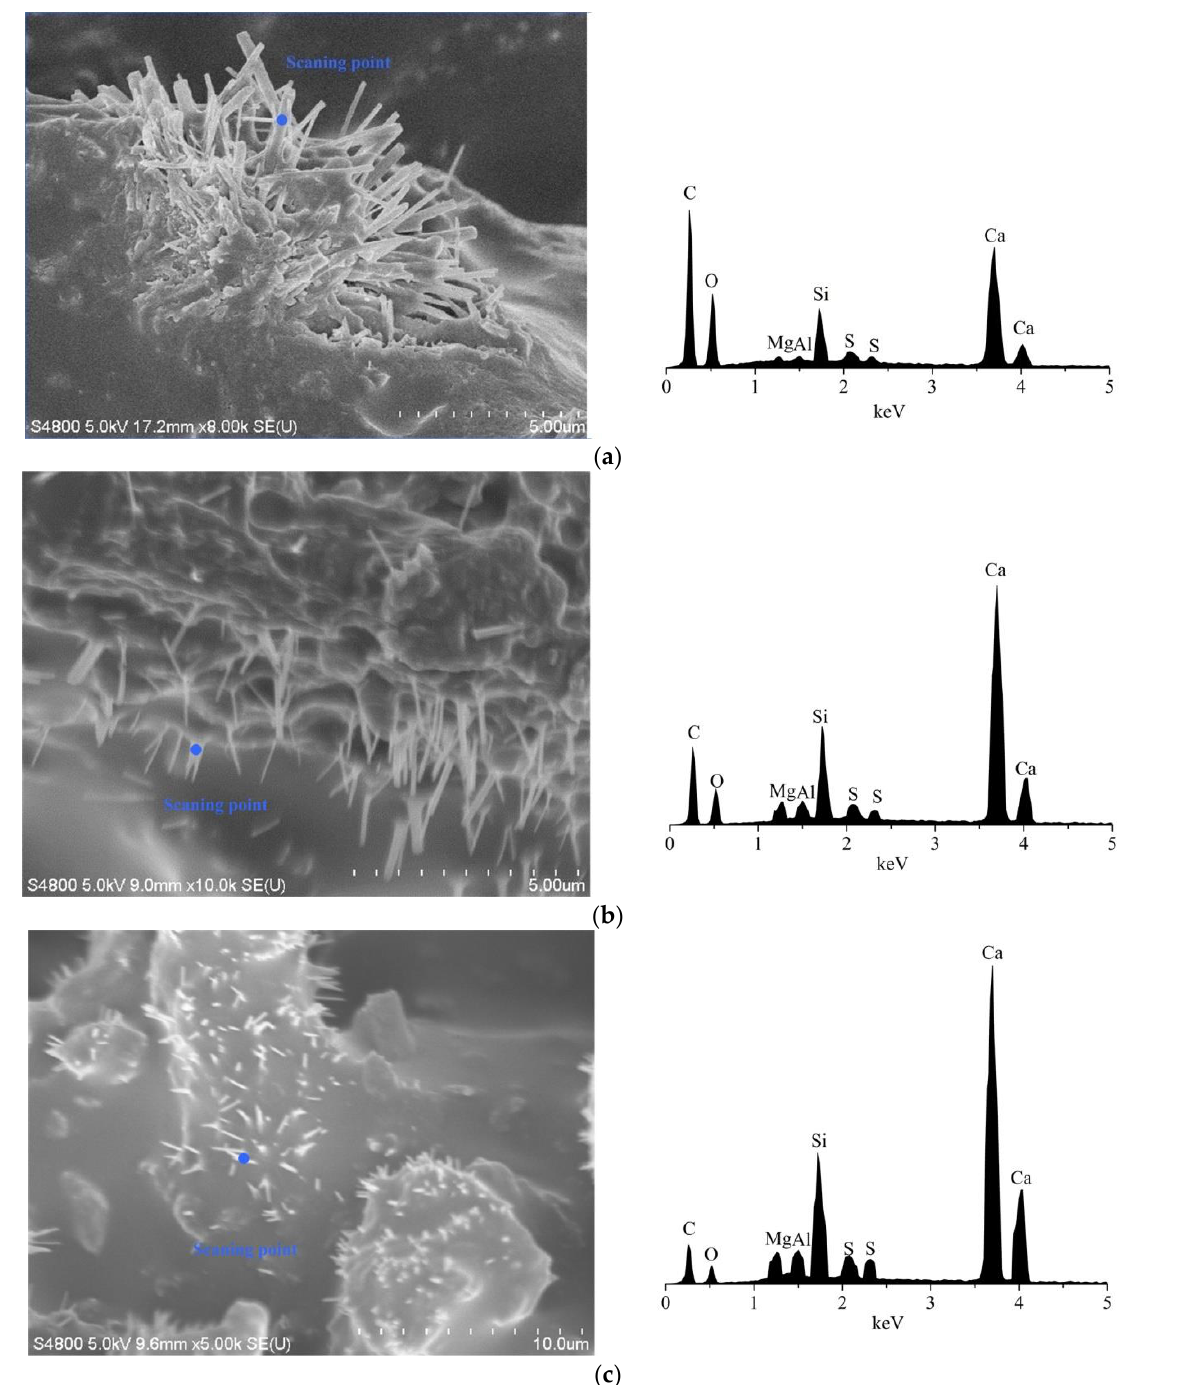
Figure 9. Chemical composition of mortar in different freeze – thaw cycles with the complete water saturation condition: ( a ) 0 freeze – thaw cycle; ( b ) 10 freeze – thaw cycles; ( c ) 20 freeze – thaw cycles.